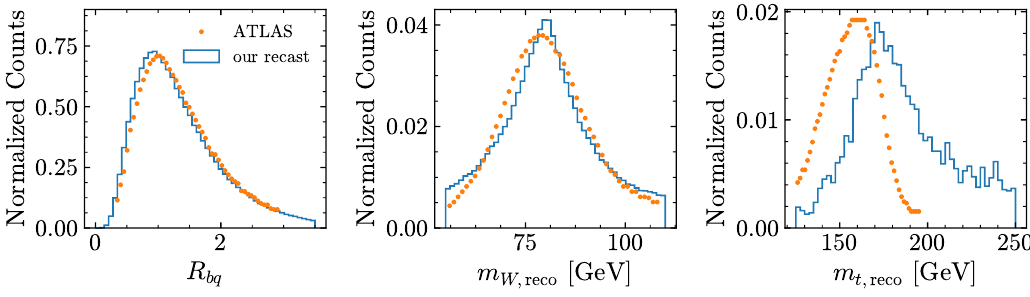
Figure 18 . This (cid:12)gure provides distributions of the three di(cid:11)erent observables used in the template analysis for the measurement of the top quark mass by ATLAS in the semi-leptonic channel. The panels from left to right show R bq which is de(cid:12)ned in eq. (3.3), m W; reco , and m t; reco , where the later two are the determined from maximizing the event-by-event likelihood de(cid:12)ned in eq. (3.2). The distributions for our analysis are shown by the solid blue histogram, while the orange dots are provided by ATLAS in [13]. We observe good agreement for the m W; reco and R bq distributions, but we are unable to reproduce the m t; reco